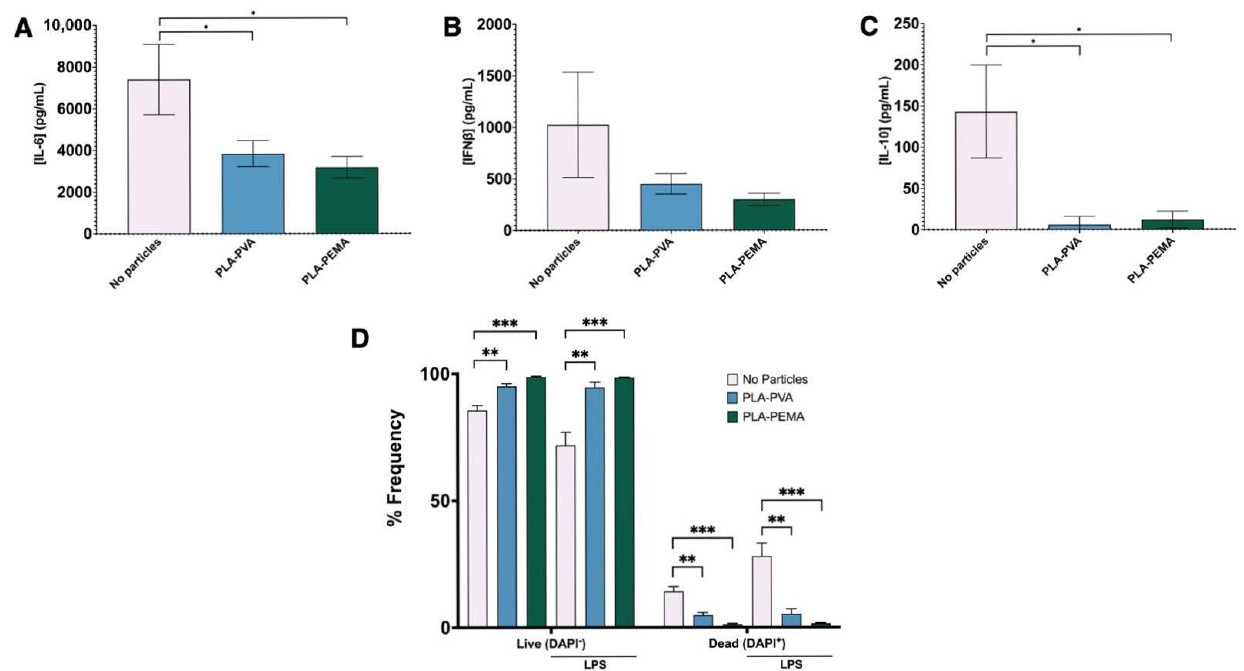
Figure 5. iNP suppression of transcription activation of genes for inflammatory cytokines result in correlated decreases in cytokine production with an increase in BMM Φ survival. Supernatants from cells incubated with LPS for 48 h following iNP treatment were also collected to assess secretion of ( A ) IL-6, ( B ) IFN β , and ( C ) IL-10, key cytokines produced downstream of TLR4 engagement. ( D ) Additionally, these cells were assessed for viability. Both iNPs, especially PLA-PEMA, result in increased survival based on flow cytometry with DAPI exclusion dye. Statistical differences between groups were determined by performing Student’s t -test. Error bars represent SD. * for p ≤ 0.05, ** for p ≤ 0.01, and *** for p ≤ 0.001.